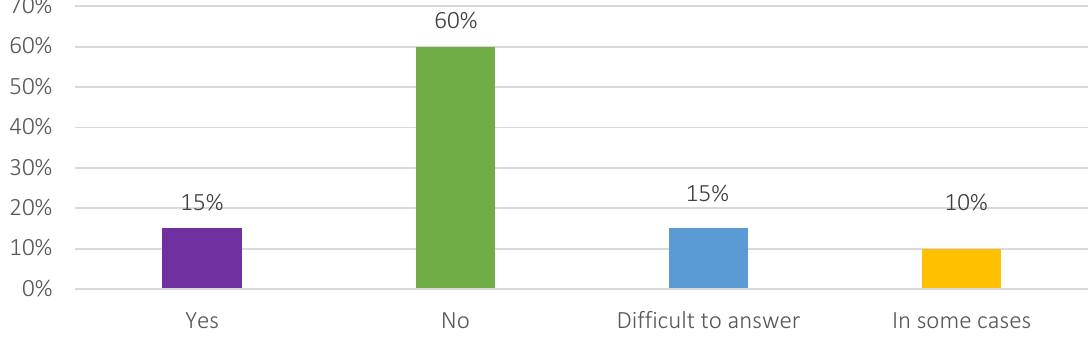
Figure 3. Features of business activity of institution of higher education,